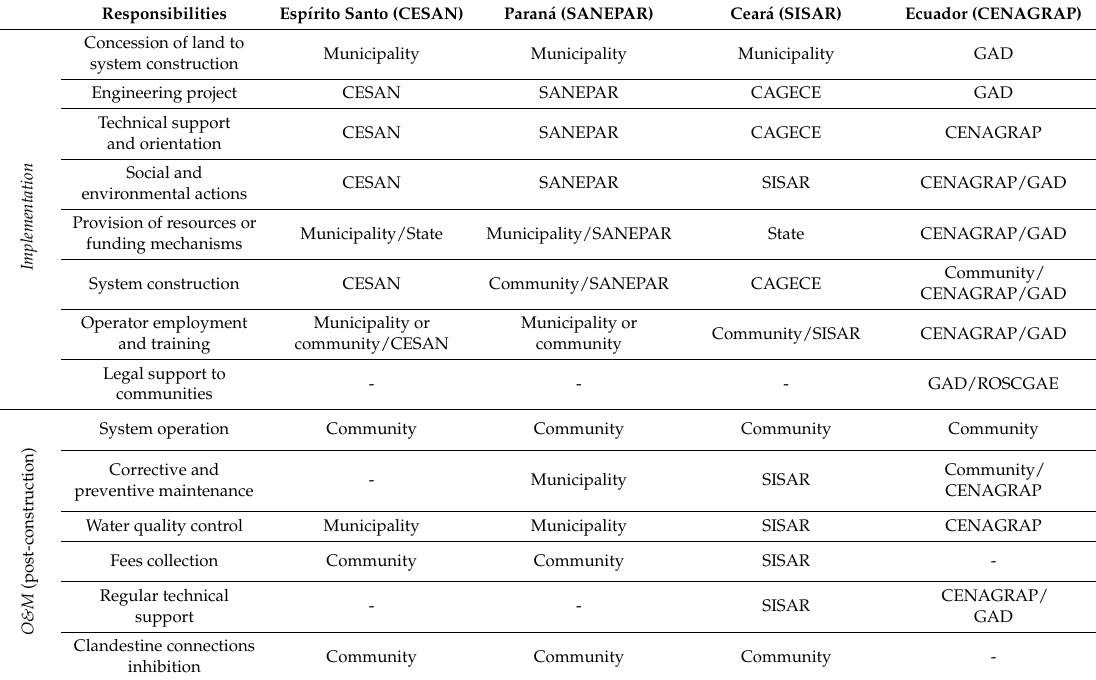
Table 1. Responsibilities of each stakeholder during the Implementation , O&M (post-construction) and Management (post-construction)